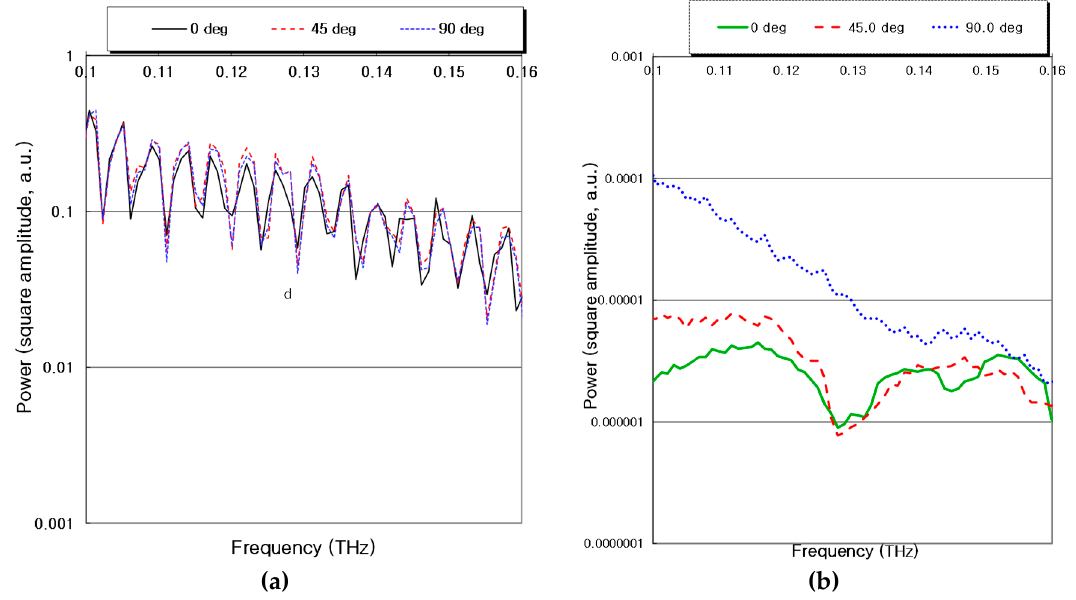
Figure 4. Relations between frequency of THz terahertz waves and transmitted power in continuous wave (CW) photo-mixing signals for a 24-ply glass and carbon composite laminates with the different functions of angles. ( a ) Glass fiber-reinforced plastic (GFRP) composites; ( b ) Carbon-fiber-reinforced plastic (CFRP) composites.